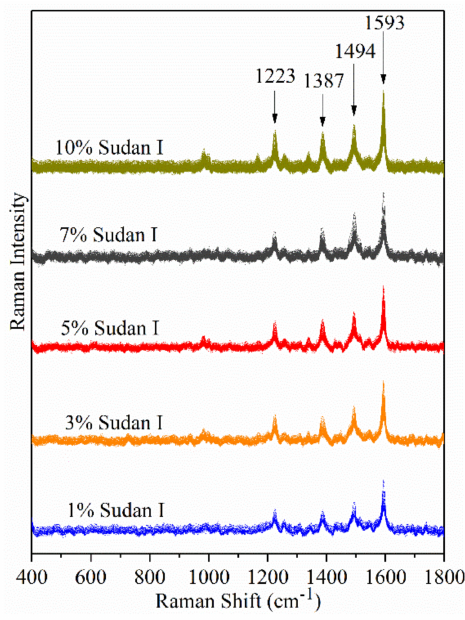
Figure 5. Raman spectra of detected Sudan-I pixels at five concentrations.